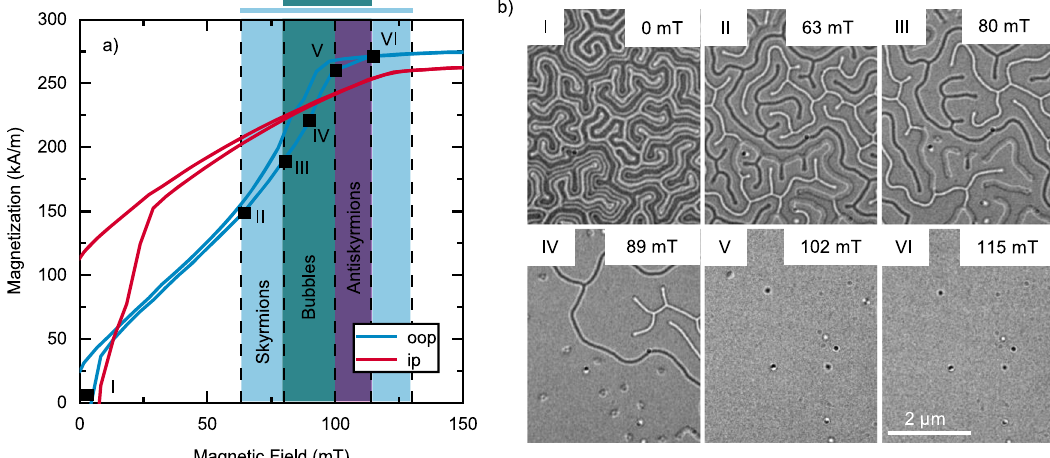
Fig. 2 Stability ranges of the spin objects. a Oop and ip M – H hysteresis loops of [Fe/Ir/Gd] 2 /[Fe/Gd] 76 /[Fe/Ir/Gd] 2 at 250 K. The colored regions mark the stability ranges of the spin objects coming from zero fi eld. b LTEM images of the sample at different oop magnetic fi elds that are also marked in the oop loop in ( a ). Panel I shows stripe domains with chirality (broader bright and dark stripes) and without (thinner stripes). At 63 mT, disordered stripes coexist with Bloch skyrmions (II). Between 80 and 89 mT, type-2 bubbles start to appear (III – IV). In panel V, all stripes disappeared and antiskyrmions nucleated at 102 mT. Antiskyrmions, skyrmions, and bubbles coexist in this fi eld range. At 115 mT, only skyrmions are stable and observable